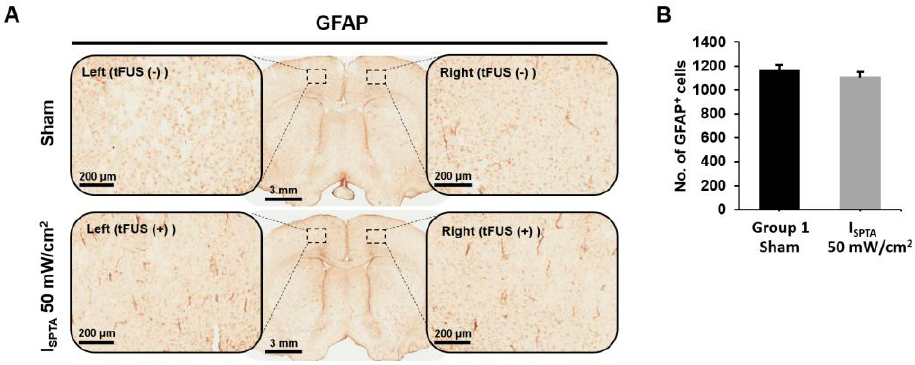
Figure 4. ( A ) Representative images of glial fibrillary acidic protein (GFAP) immunostaining and examples of GFAP images after sham tFUS and tFUS at an I SPTA of 50 mW/cm 2 . ( B ) No significant difference was observed between the two groups in the GFAP of the right hemisphere.